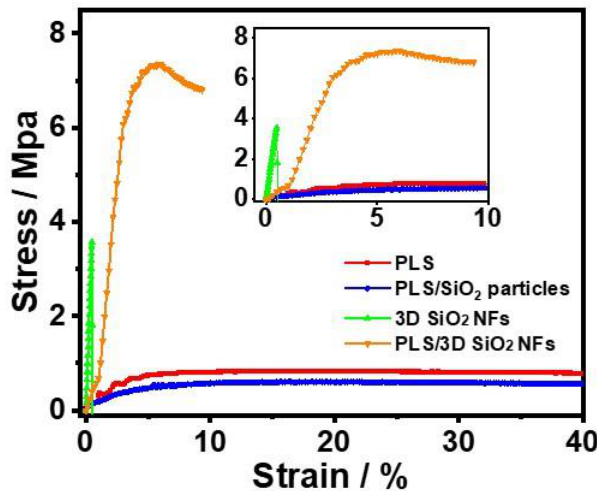
Figure 1. The top view ( a ) and cross-sectional views ( b , c ) of polyethylene oxide–lithium (bis trifluoromethyl) sulfate–succinonitrile (PLS) / SiO 2 particles. Agglomeration of SiO 2 nanoparticles in the PLS can be seen. The top view ( d ) and cross-sectional views ( e , f ) of PLS / 3D SiO 2 nanofibers (NFs) . Uniform distribution of PLS in the framework of 3D SiO 2 NFs can be seen.